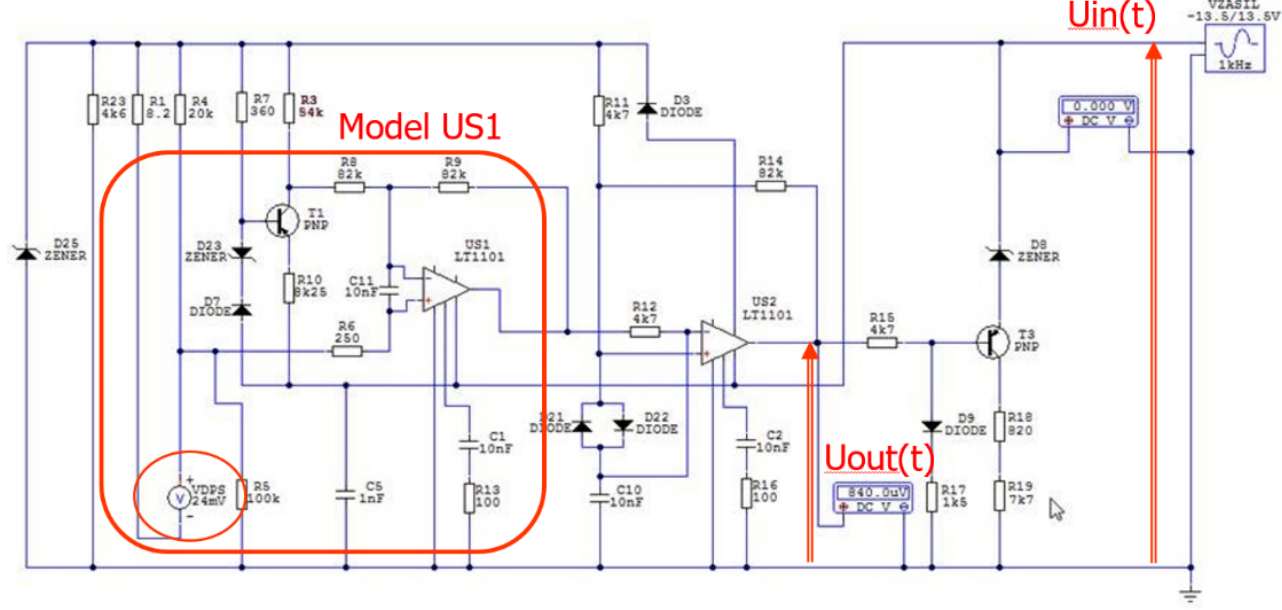
Figure 6. Conceptual diagram of the US1 amplifier model in the SSP − FK − BI execution block.